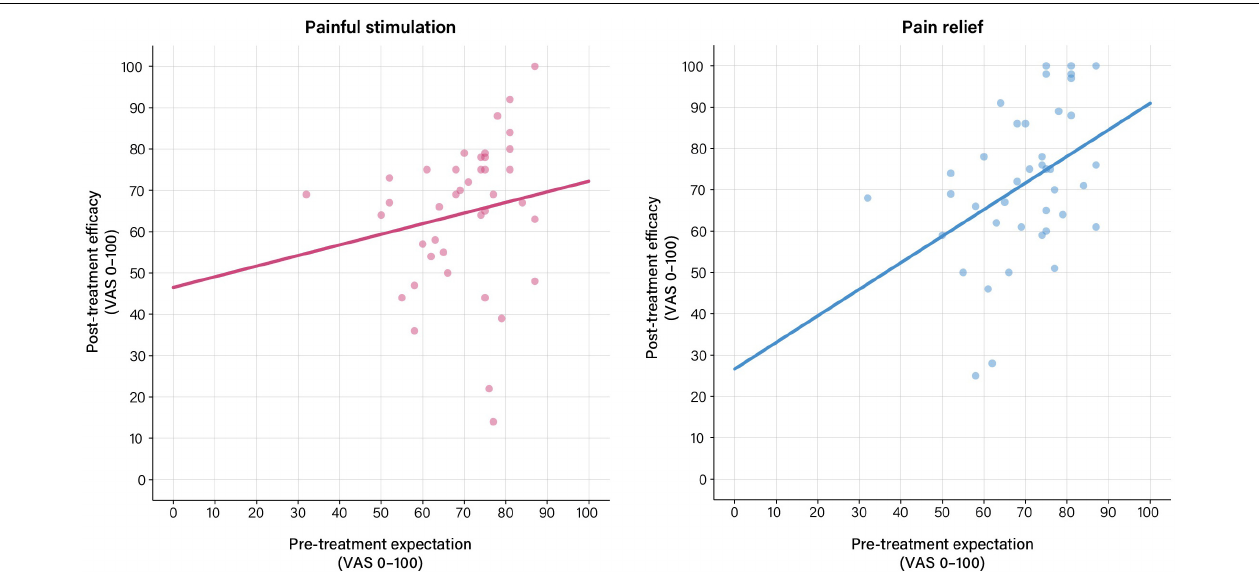
FIGURE 2 | Associations between pre-treatment expectation and perceived treatment efficacy based on general linear models (GLM) calculated using pre-treatment expectation as exploratory and treatment efficacy ratings as response variables. (Left) No significant association between pre-treatment expectation and perceived treatment efficacy was found after painful stimulation in the pain phase. (Right) For the relief phase, pre-treatment expectations were significantly associated with perceived treatment efficacy ( b = 0.35, t = 2.37, p = 0.024). For details, see Table 2 . For results after exclusion of outliers, see Supplementary Table 3 and Supplementary Figure 1